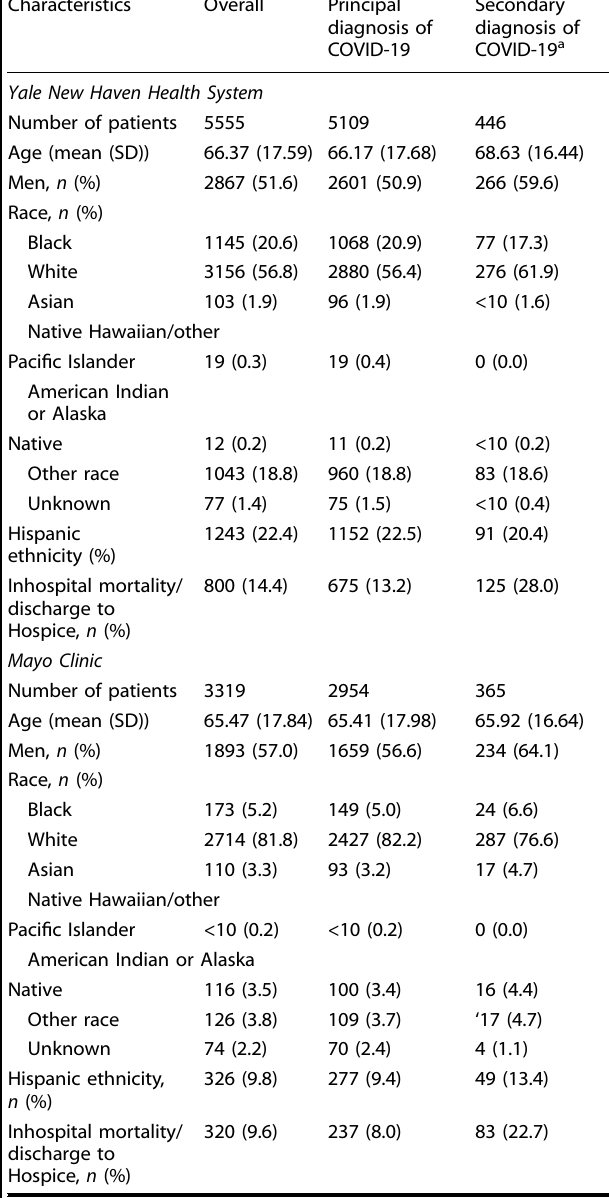
Table 2. Characteristics of hospitalized COVID-19 patients with a principal or secondary diagnosis of COVID-19 (U07.1).